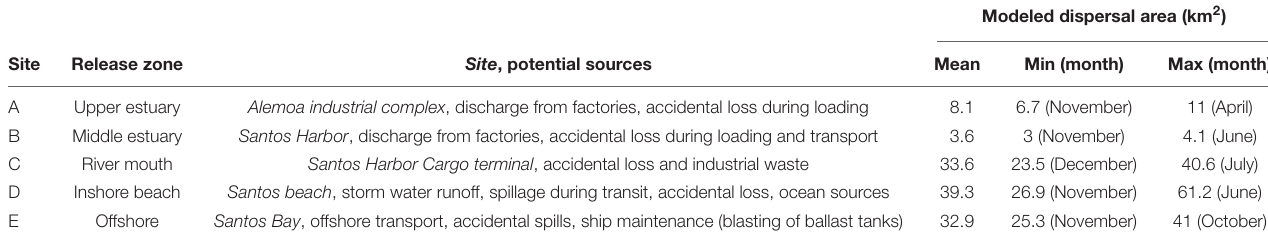
TABLE 1 | Summary of simulated release points within the SES and nearshore zones, potential sources, and modeled dispersal